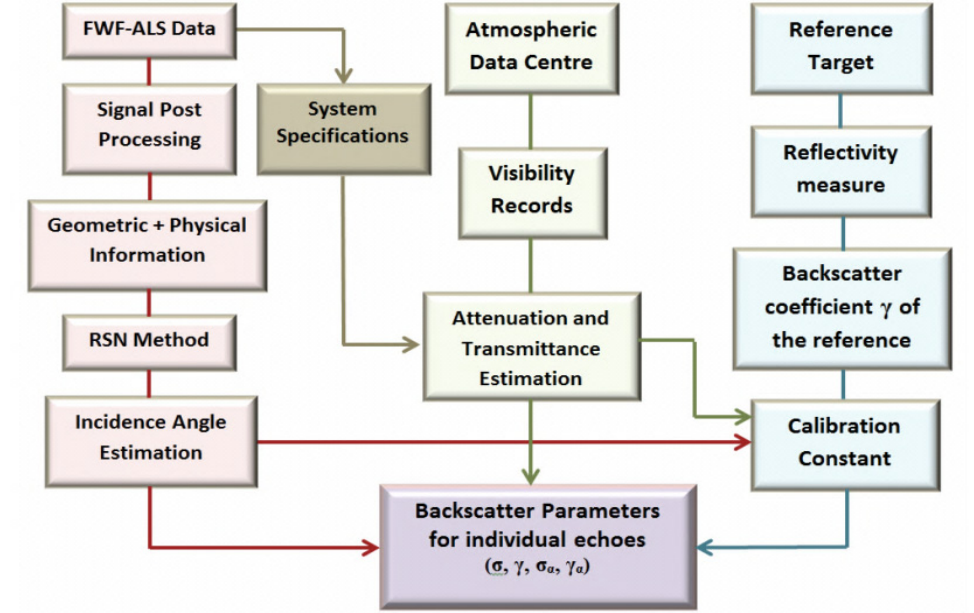
Figure 2. Flowchart illustrating the developed radiometric calibration